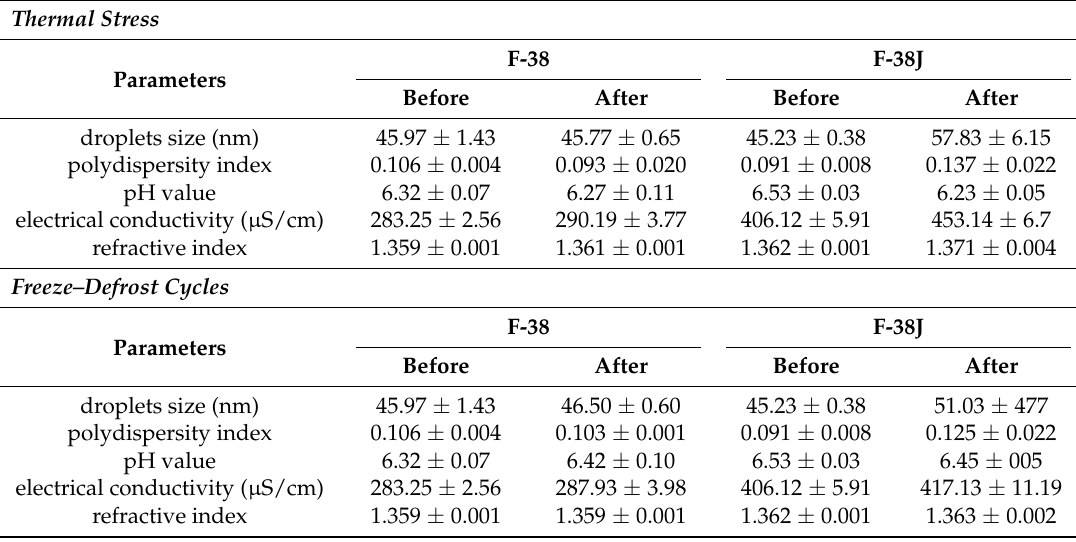
Table 4. Thermal stress and freeze–defrost analysis for F-38 and F-38J babassu nanoemulsions oil.